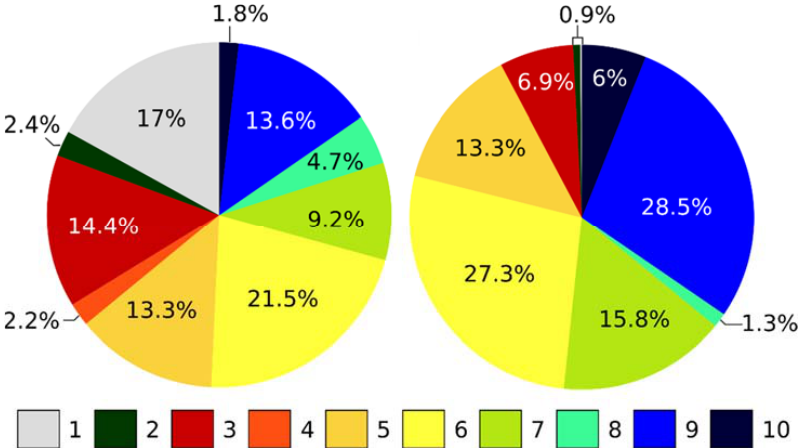
Figure 2. The distribution of terrain forms over the study site ( left diagram) and the landslides ( right diagram) 1 = flat; 2 = summit; 3 = ridge; 4 = shoulder; 5 = spur; 6 = slope; 7 = hollow; 8 = footslope; 9 = valley; 10 = depression. Terrain forms were calculated and named after Jasiewicz and Stepinski [83].